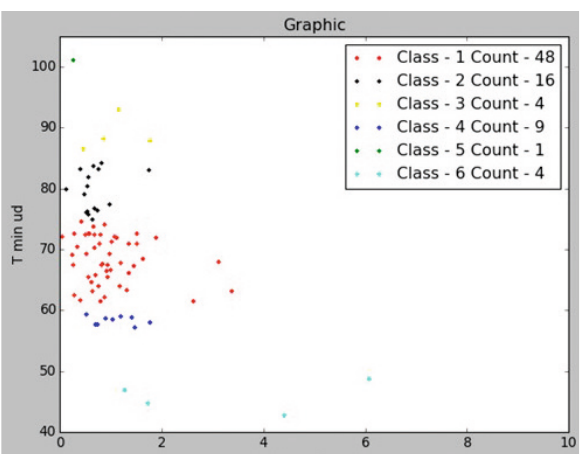
Figure 4. Clustering routes with a radius of seven